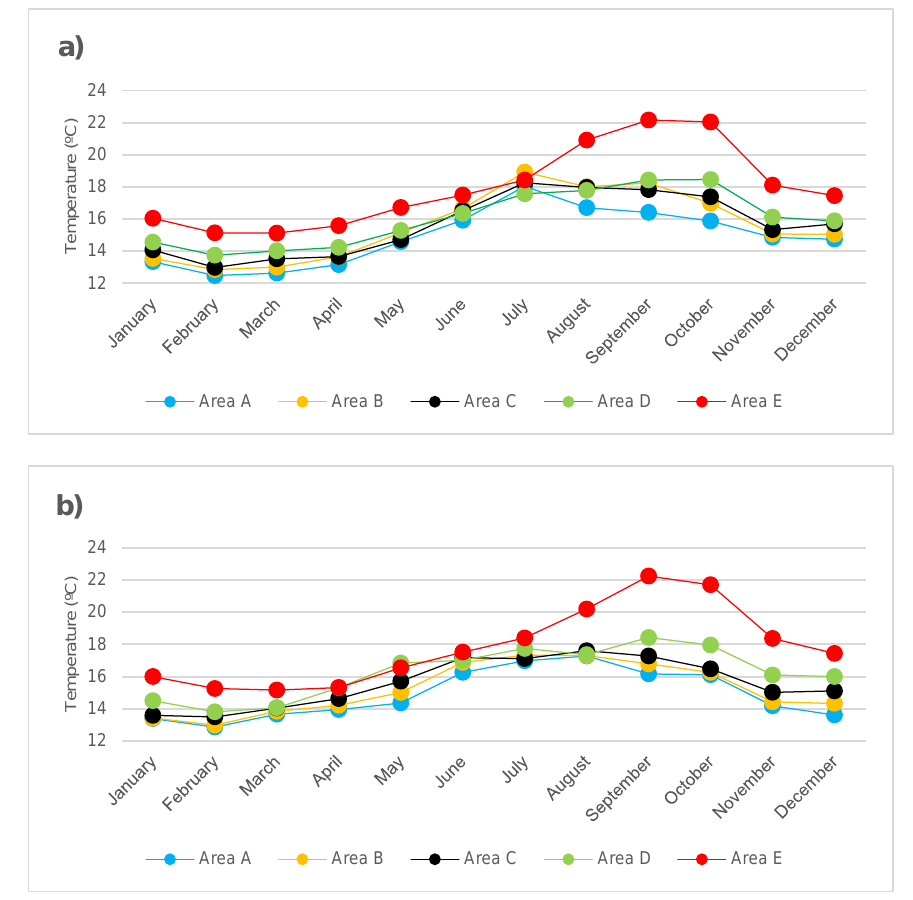
Figure 2. Mean monthly temperature (°C) of the water surface (up to 1 m deep) in the 5 study areas ( a ) 2018 and ( b ) 2019 (water temperature data based on satellite reanalysis data).